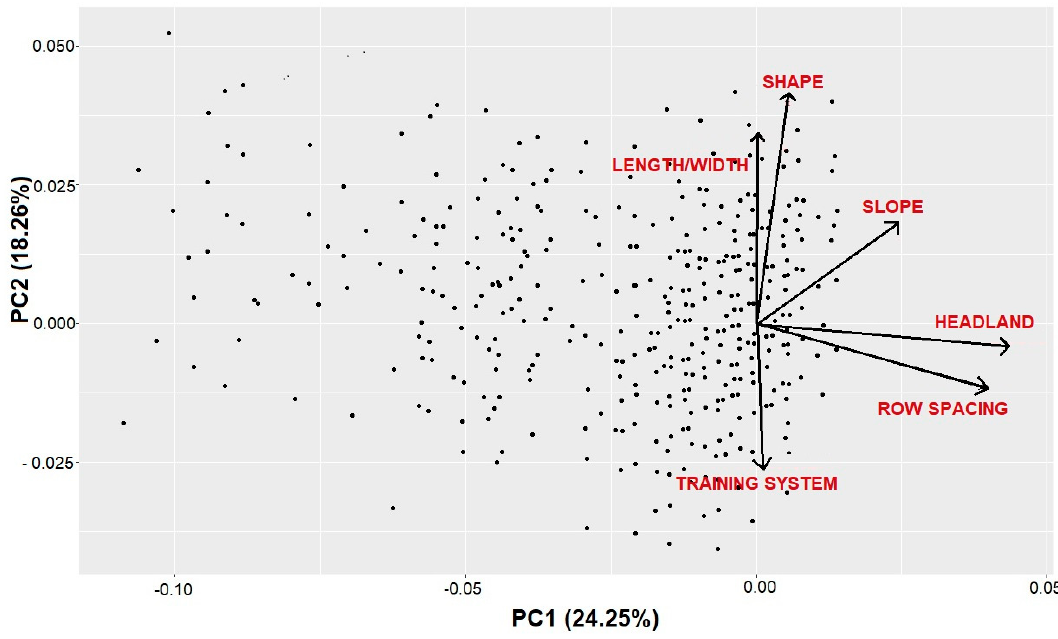
Figure 5. Principal component analysis (PCA) with loading plots related to the first (PC1) and second components (PC2).